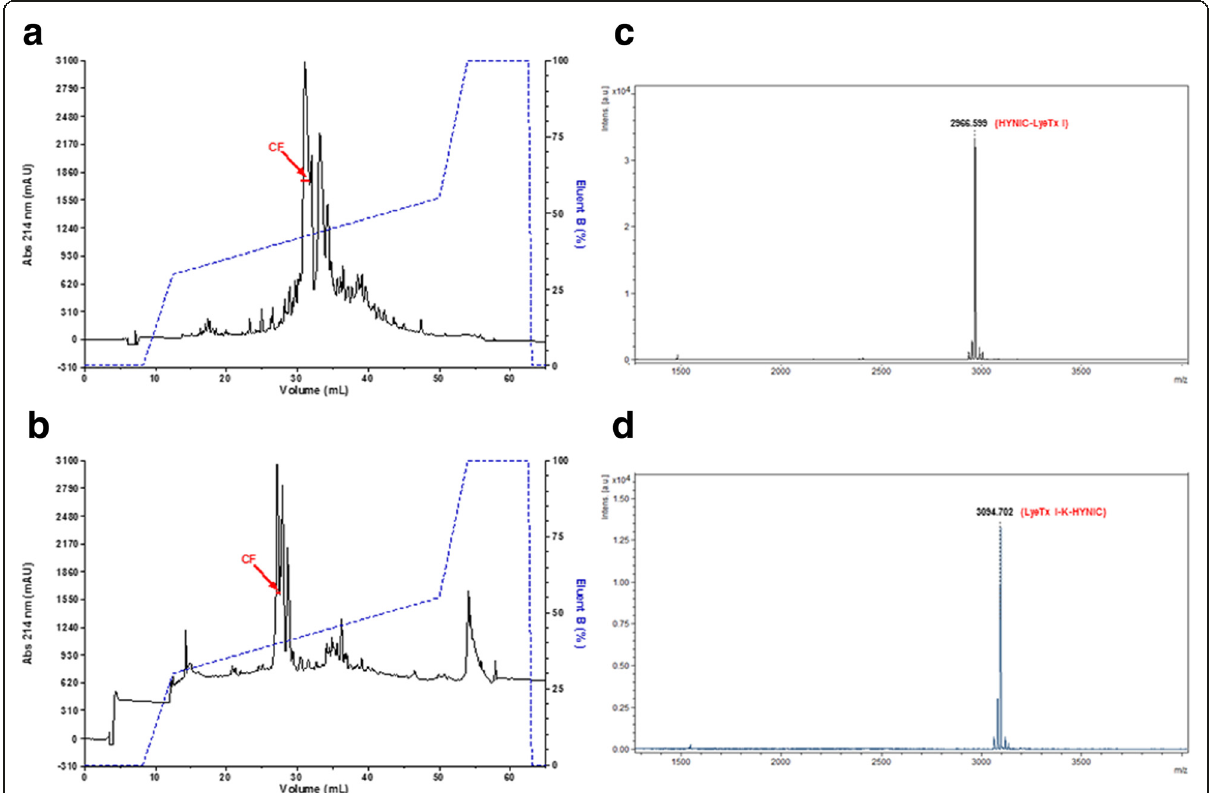
Fig. 2 Purification of synthetic crude peptide LyeTx I derivatives modified with the chelating agent HYNIC, by RP-HPLC (Ettan LC, GE HealthCare, USA). Chromatograms of synthetic crude a HYNIC-LyeTx I and b LyeTx I-K-HYNIC: Discovery® BIO Wide Pore C8 column (5 μ m, 250.0 mm × 4.6 mm) equilibrated with 0.1 % (v:v) TFA in water (eluent A) and eluted by a linear gradient of 0.1 % (v:v) TFA in acetonitrile (eluent B); the flow was 1.0 mL . min − 1 and the detection was at 214 nm. Mass spectrometer (MS) spectra of the collected fraction (CF) of synthetic purified c HYNIC-LyeTx I and d LyeTx I-K-HYNIC: the molecular weights were 2966 Da and 3094 Da, respectively, obtained by deconvolution of the MS spectra